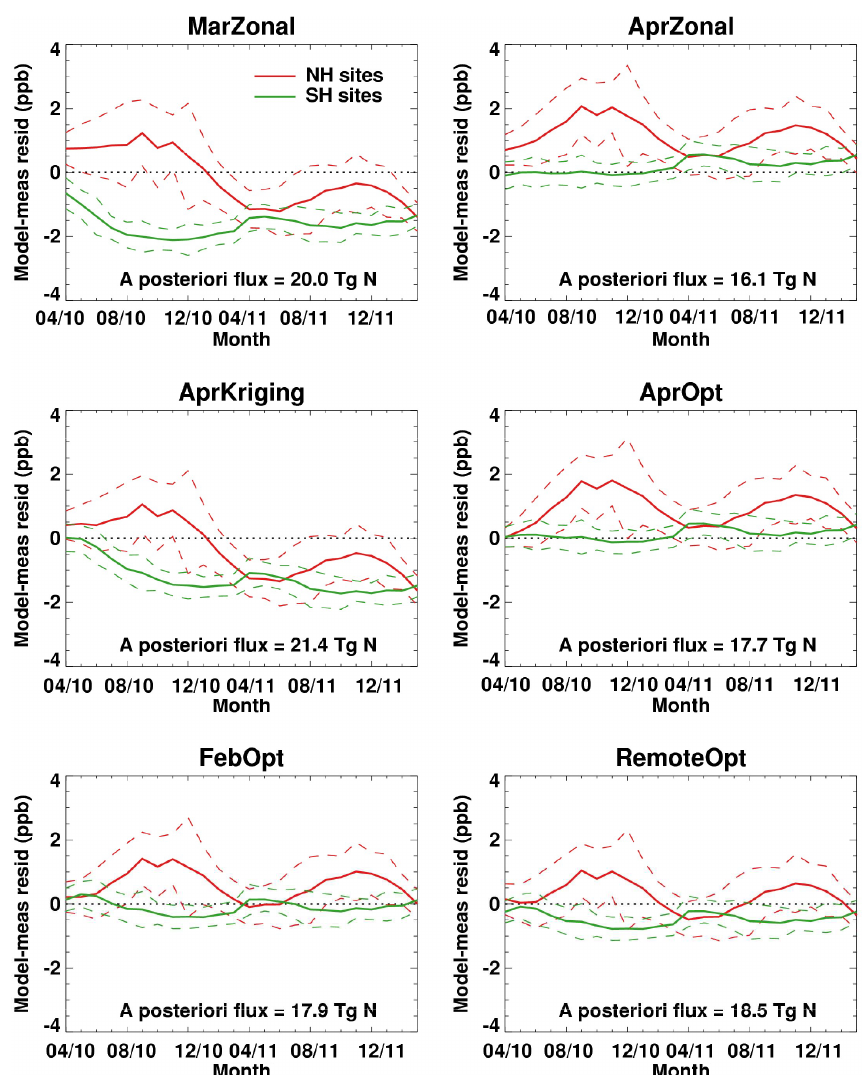
Figure 2. Impact of initial conditions on a 2-year (April 2010–April 2012) N 2 O simulation and inversion. Shown are timelines of the model– measurement residuals for a 2-year forward model simulation initialized using each of the six initial conditions listed in Table 1. The solid line represents the mean and the dashed lines represent the standard deviation about the mean for Northern Hemisphere (red) and Southern Hemisphere sites (green). The final 2011 a posteriori global flux for each simulation derived using a standard 4D-Var inversion is noted at the bottom of each